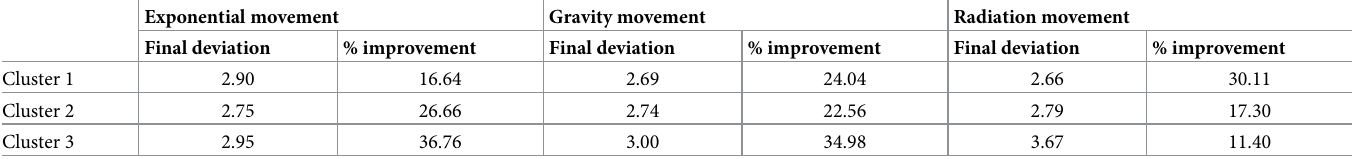
Table 2. Final values of the objective function (d) across and within clusters and its improvement between rounds 1 and 3 of sequential Monte Carlo rounds. Exponential